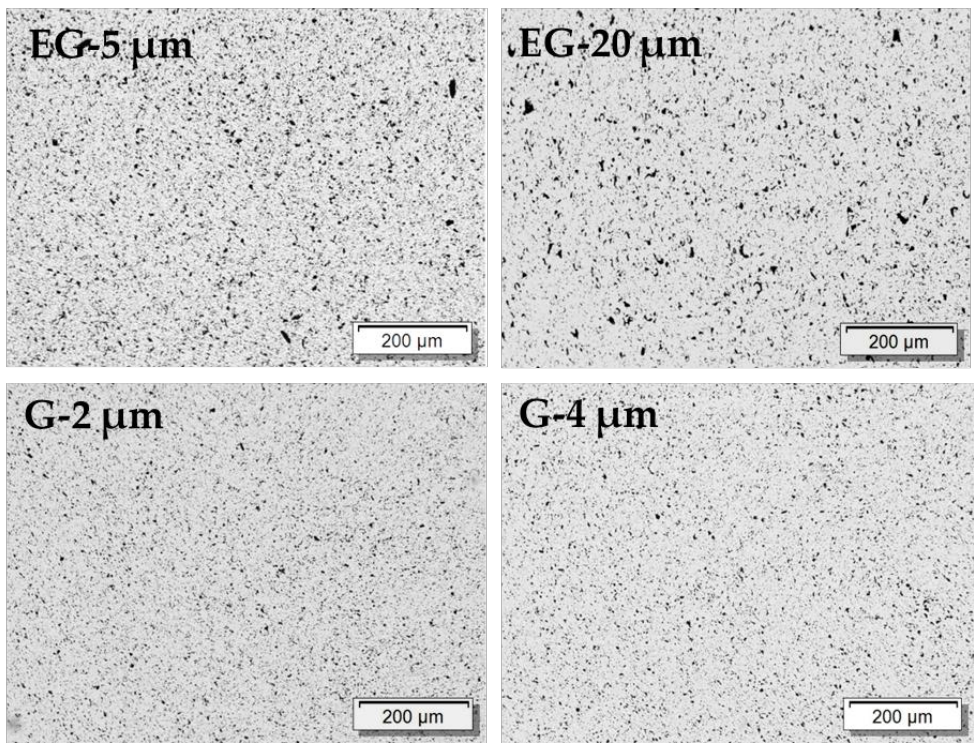
Figure 6. Transmission light microscopy images of PVDF/1.0 wt% composites filled with different kinds of expanded graphite (EG) and graphite (G).